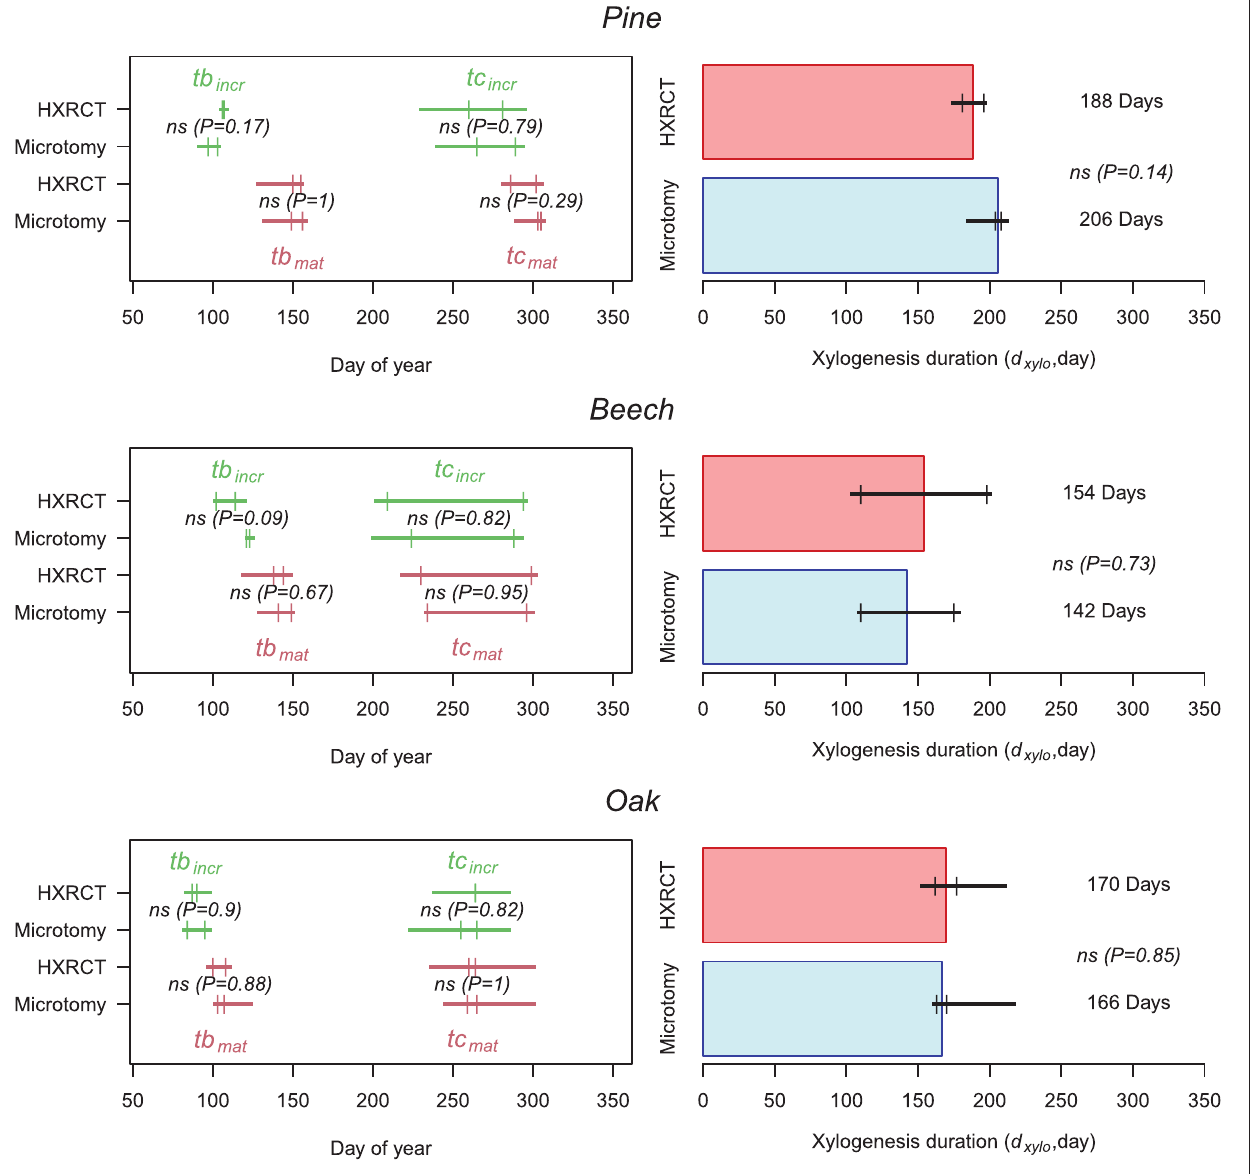
FIGURE 7 | Xylogenesis calendar and duration. Left panels: Estimates of size growth beginning ( tb incr ) (i.e., beginning of xylogenesis) and size growth ending ( te incr ) (green) as well as mature xylem production beginning ( tb mat ) and ending ( te mat ) (i.e., ending of xylogenesis) (brown) are presented for HXRCT and microtomy. Green and brown lines range from minimum to maximum estimated dates, while second and third quartile are represented by short vertical lines. Right panels: Estimates of xylogenesis duration ( d xylo ) (median) for HXRCT (red) and microtomy (blue) are presented. Black lines range from minimum to maximum estimated duration, while second and third quartile are represented by short vertical lines. The significance of the bootstrap resampling test (P) assessing the difference between HXRCT and microtomy is